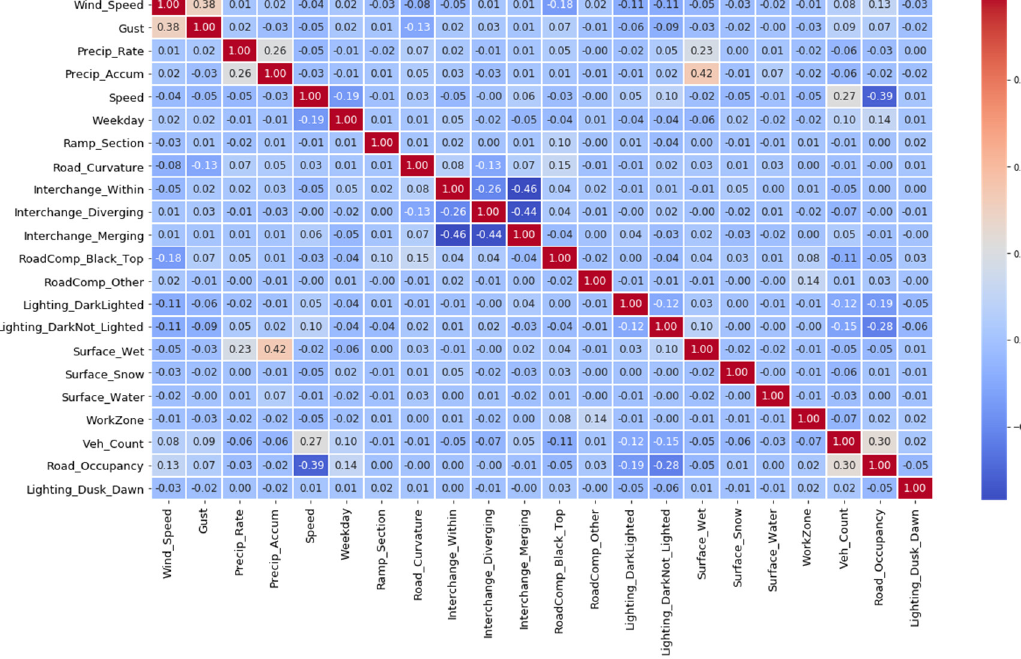
Figure 4. Correlations of RTWE features.